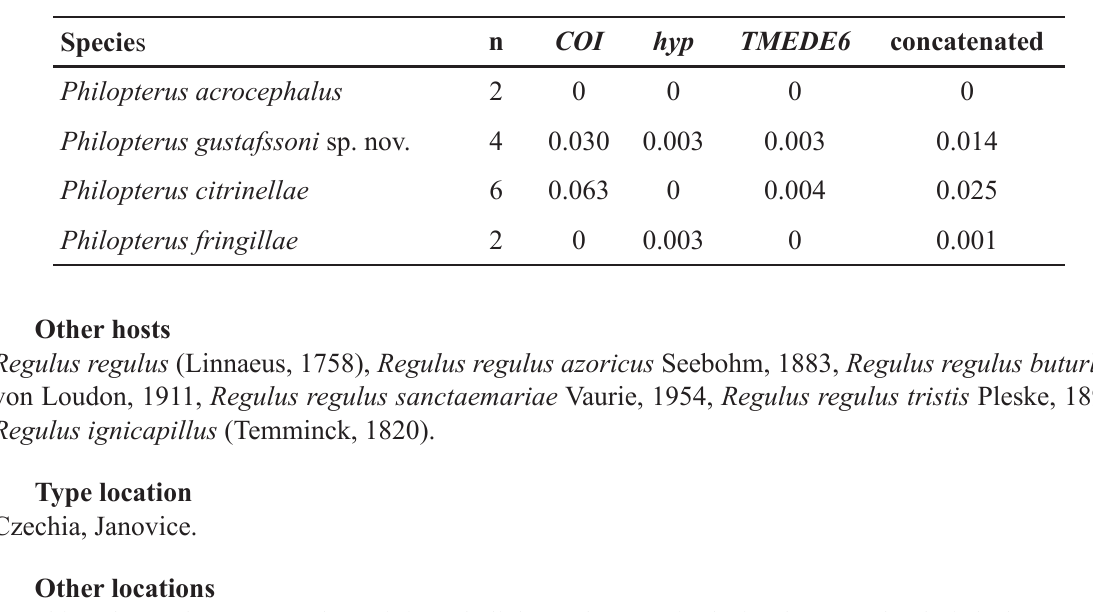
Table 4. Average intraspecific p -distances of examined specimens of Philopterus acrocephalus Carriker, 1949, Philopterus gustafssoni sp. nov., Philopterus citrinellae (Schrank, 1776) and Philopterus fringillae (Scopoli, 1772) computed from COI , hyp , TMEDE and concatenated gene